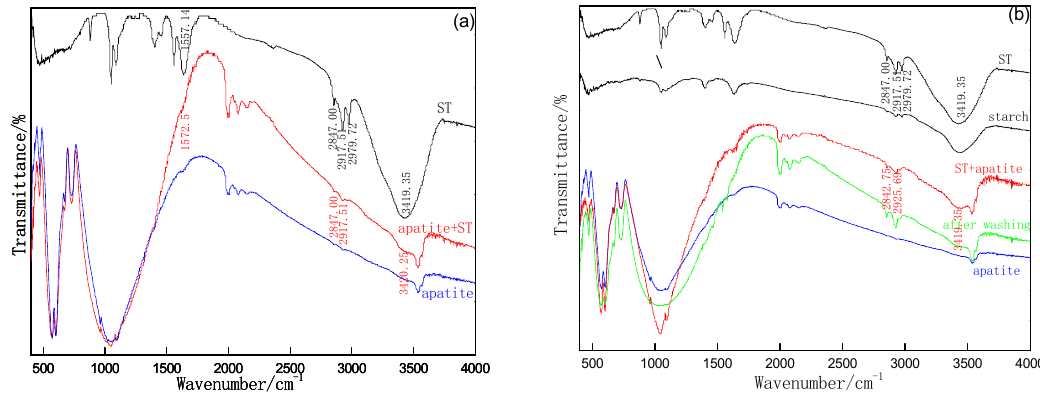
Figure 13. Infrared spectra of apatite before and after action of ( a ) toluenesulfonamide(ST) and ( b ) starch and